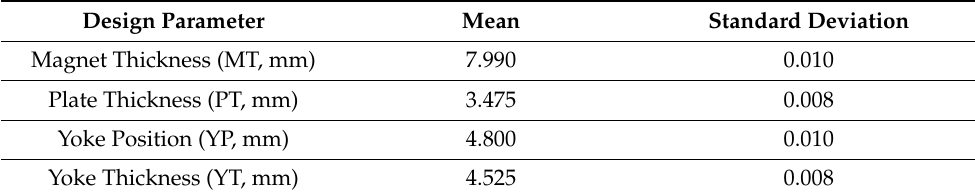
Figure 21. Probability distribution of performance factor for 3 sigma level. Table 8. Mean and standard deviation for the design